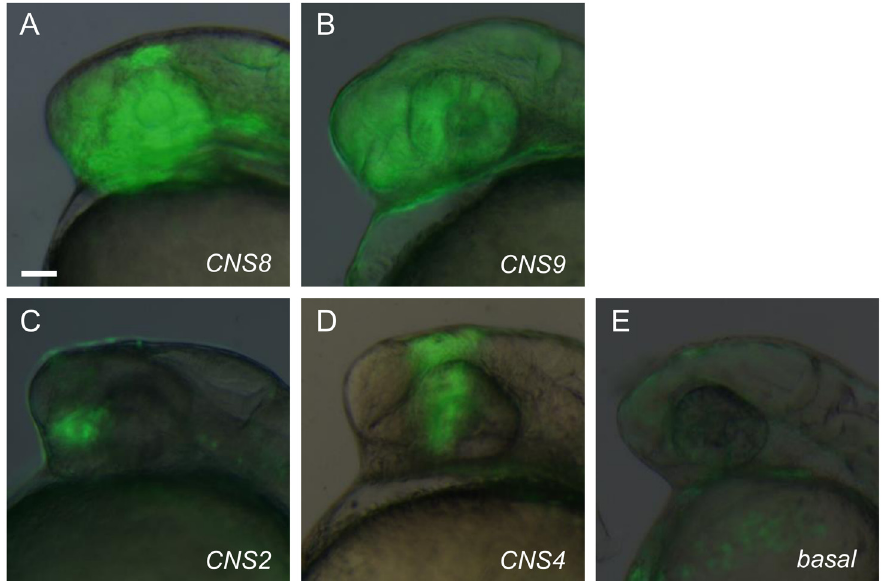
Fig 2. Region specific enhancer activity of the identified CNSs. ( A-B ) CNS8 and CNS9, located in the vicinity of the lhx5 promoter region give rise to broad reporter EGFP expression in the forebrain regions. ( C ) CNS2 located approximately 50 kb upstream of the lhx5 coding region gives rise to restricted EGFP signal in the anterior ventral forebrain. ( D ) CNS4 located 40 kb upstream of the lhx5 coding region, gives rise to restricted EGFP expression in the diencephalic region. ( E ) Vector construct gives rise to basal non-tissue specific EGFP expression in transient expression assay. Lateral view of the forebrain regions of embryos at 24 hpf, anterior to the left. Scale bar: 50 μ